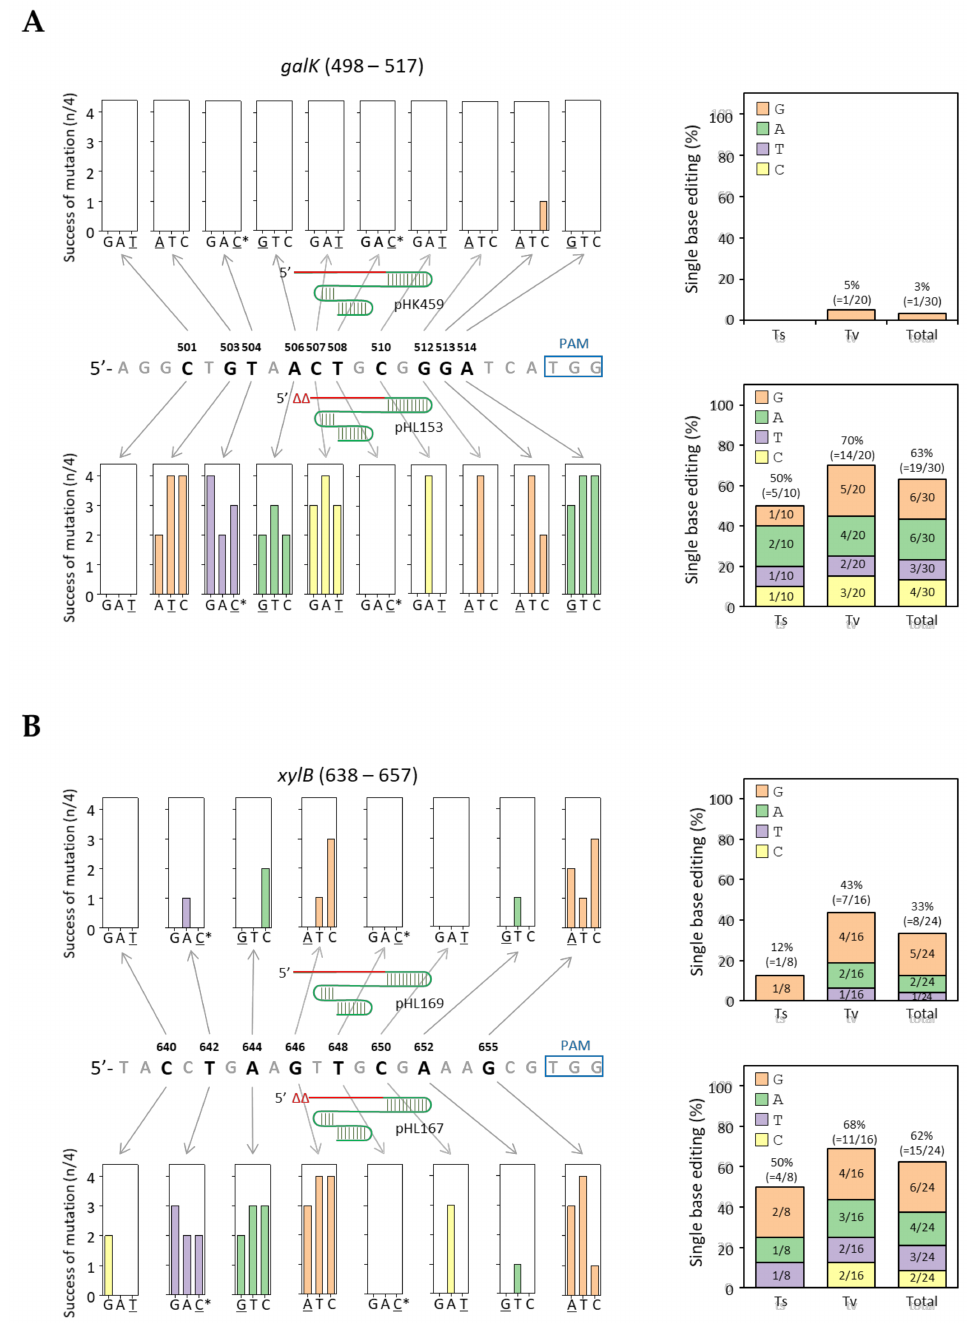
Figure 3. Efficiency of truncated sgRNA-mediated single-base editing in randomly selected colonies. Location of mutation sites and results of single-base editing of various bases in galK ( A ) and xylB ( B ) targets. Single-base genome editing efficiency divided by mutation types (right). The numbers in the colored boxes and parentheses indicate the frequency and success of single-base genome editing, respectively. * Four single-base edits generate a G:U wobble-base pairing. Underlined bases indicate a transition mutation. Notably, there were twice as many transversion cases than transition alteration